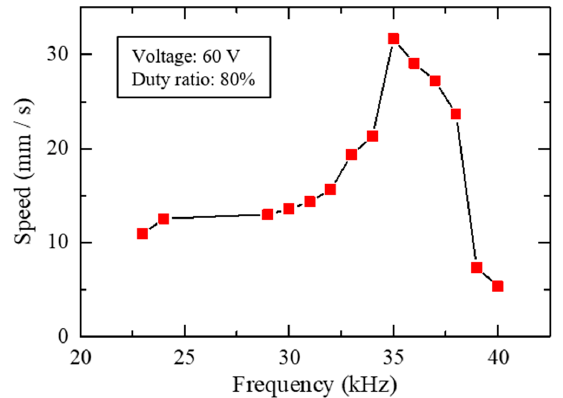
Figure 12. Driving characteristics of the slider 1 at different frequencies.